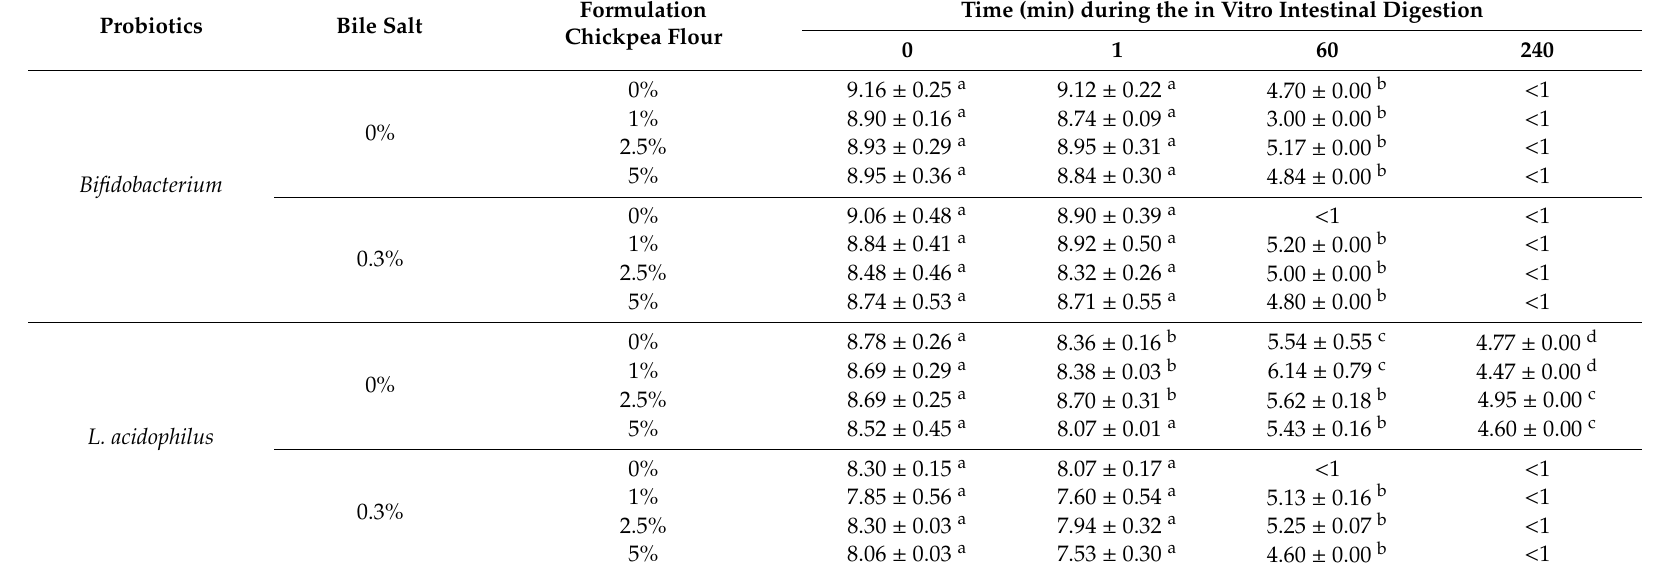
Table 4. E ff ect of simulated intestinal juices (with or without 0.3% bile salt, pH 8.0) on the viability of probiotics in yogurt formulations containing chickpea flour during 240 min of exposure (viable counts shown as log CFU / g, n =